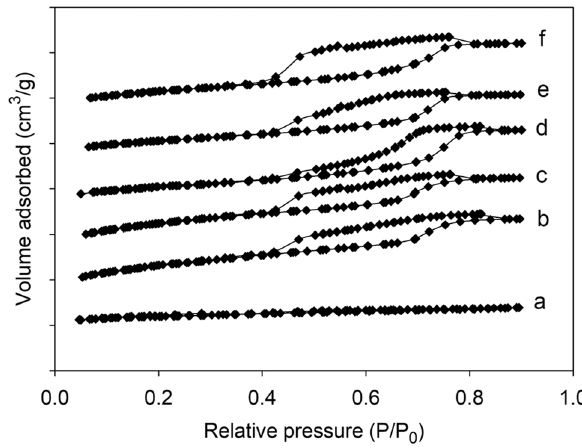
Fig. 3 N 2 adsorption–desorption isotherms of the catalysts: a B300, b BC27, c BC48, d BC0.7, e BC11.1, and f BC5.7